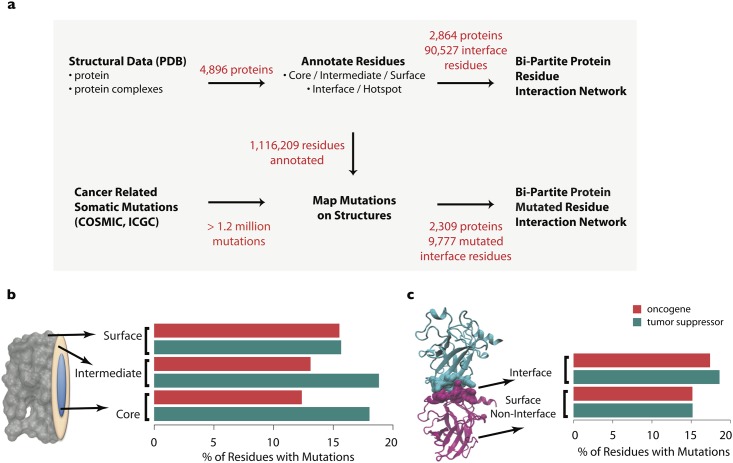
An overview of the analyses performed.a) A workflow describing the data processing steps from protein structures in the PDB and cancer-related somatic mutations in COSMIC and ICGC to residue-level bi-partite protein interaction networks. b) The percentage of residues within surface, intermediate and core regions that harbor mutations for oncogenes (n = 56) and tumor suppressors (n = 47) with 3D structures. c) Focusing only on surface residues, the percentage of residues within interface and non-interface regions that harbor mutations for oncogenes and tumor suppressors with 3D structures.